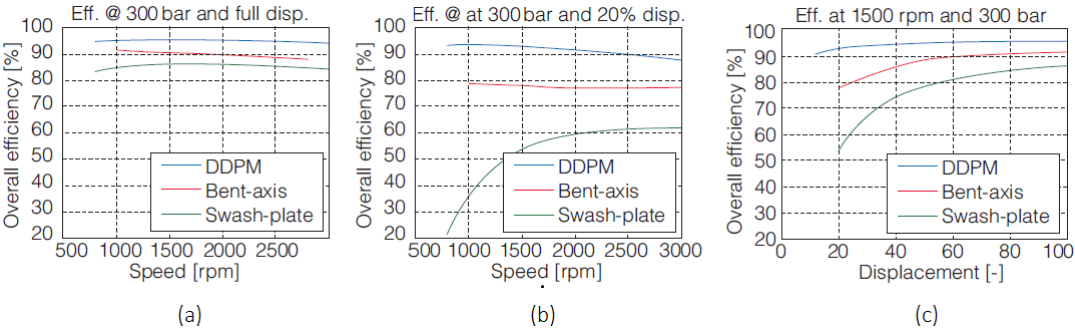
Figure 11. Efficiency comparison between bent-axis, swash-plate and Digital Displacement hydraulic motors [13]. (a) shows the efficiency at constant pressure (300 bar) and full displacement, (b) at constant pressure (300 bar) and 20% displacement and (c) at constant rotational speed (1500 rpm) and pressure (300 bar). A contribution by Rico H.